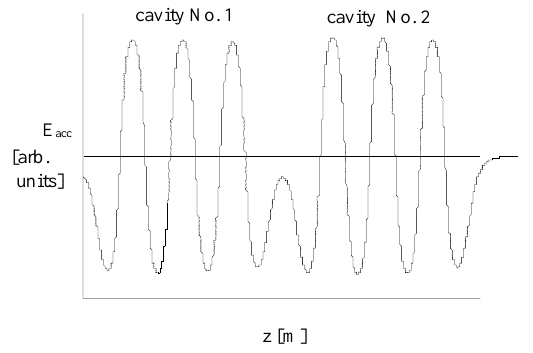
FIG. 3. An example of (cid:69) (cid:97)(cid:99)(cid:99) vs (cid:122) in two neighboring 7-cell cavities excited in the p (cid:45)(cid:48) mode.